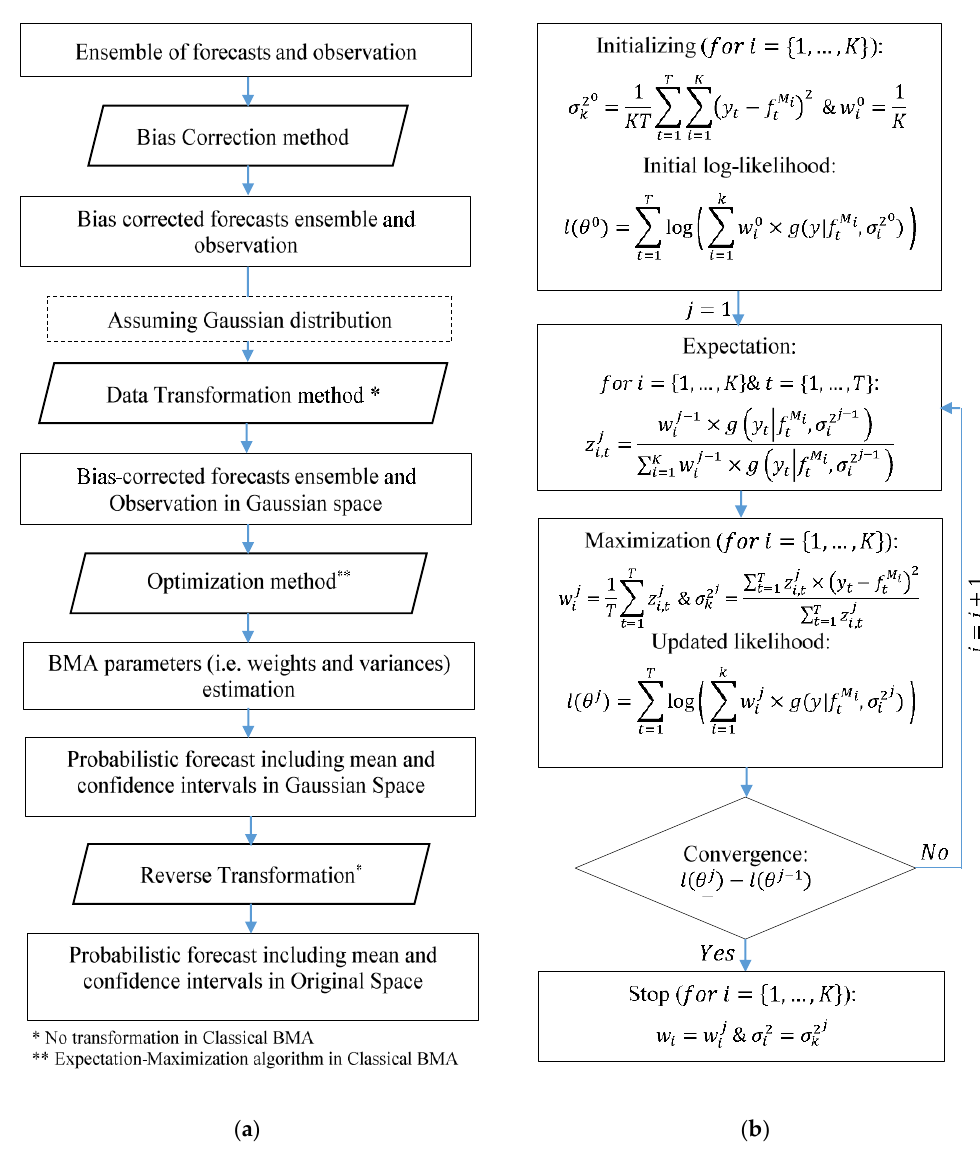
Figure 4. The flowcharts for ( a ) standard Bayesian model averaging (BMA) and ( b ) the step-by-step procedure of the expectation-maximization (EM)